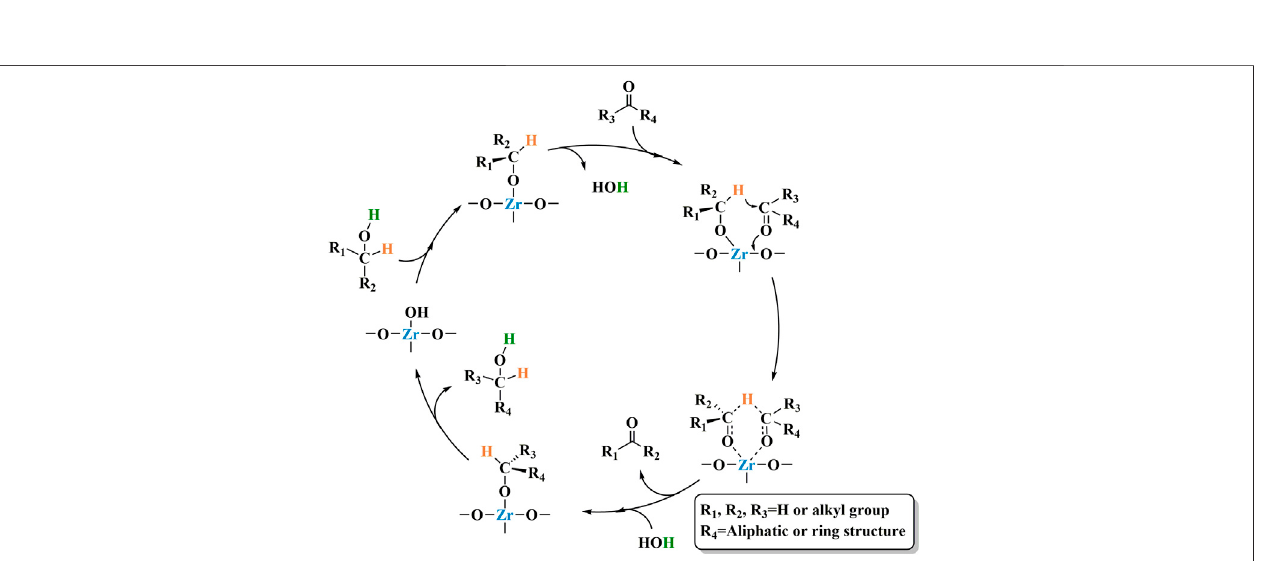
which generally have relatively large speci fi c surface areas, large